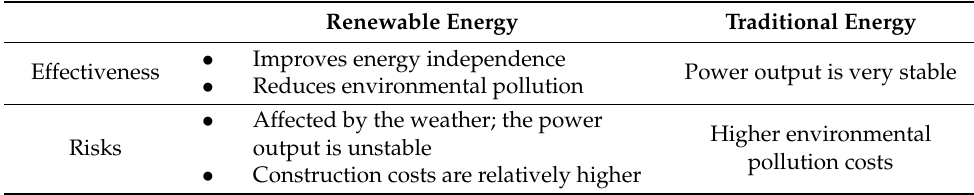
Table 1. The effectiveness and risks of traditional energy and renewable